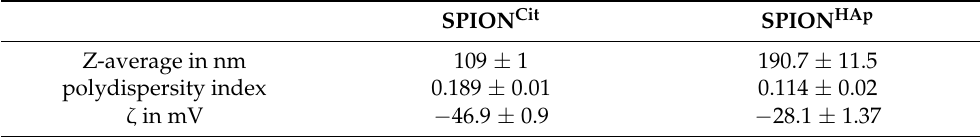
Figure 1. SEM images of ( a ) SPION Cit and ( b ) SPION HAp and corresponding EDX signal. Table 1. Parameters of SPION Cit and SPION HAp . Measurements were performed in triplicate.